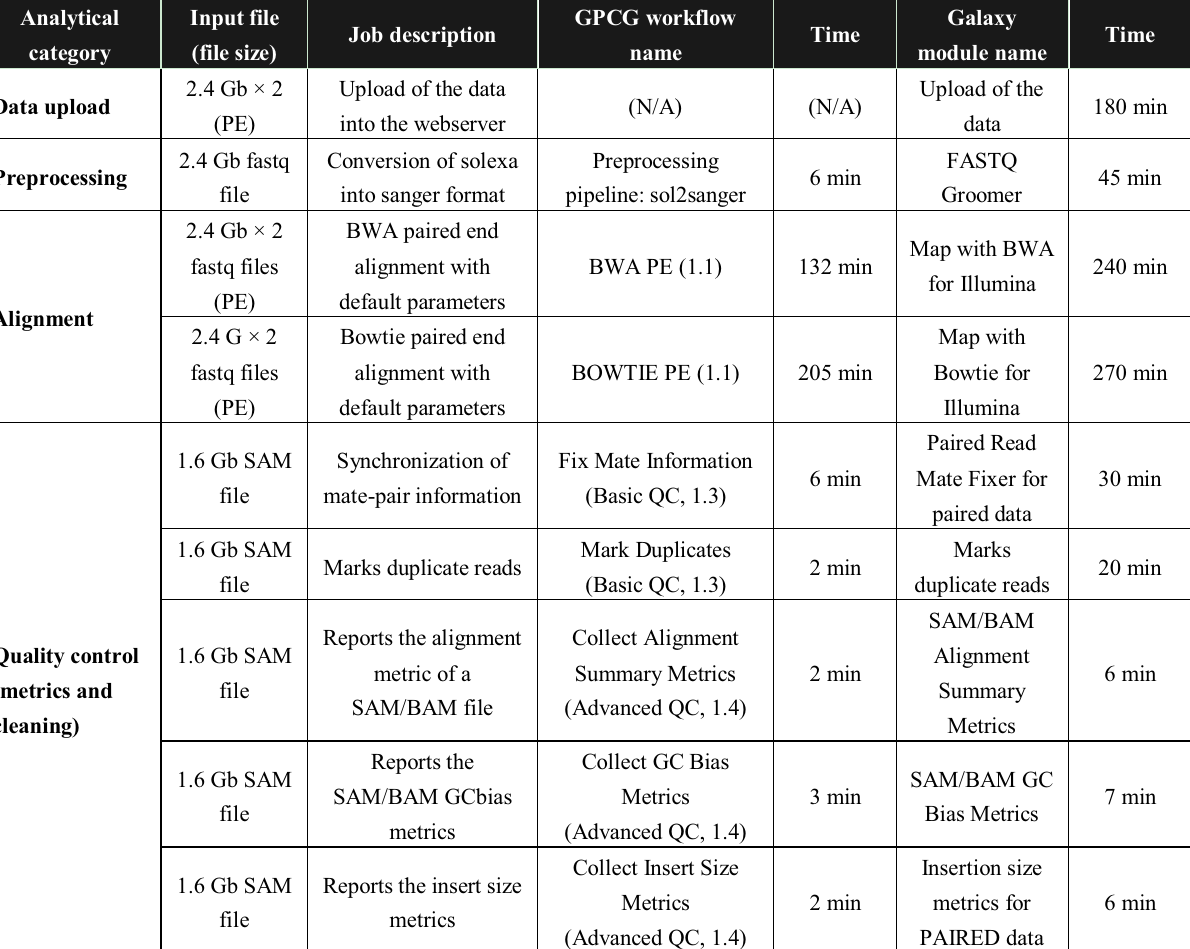
Table 4. Runtimes and performances on simulated data for modules in common across Graphical Pipeline for Computational Genomics (GPCG) and Galaxy. The performances of GPCG in terms of run time were better than Galaxy for all the tested